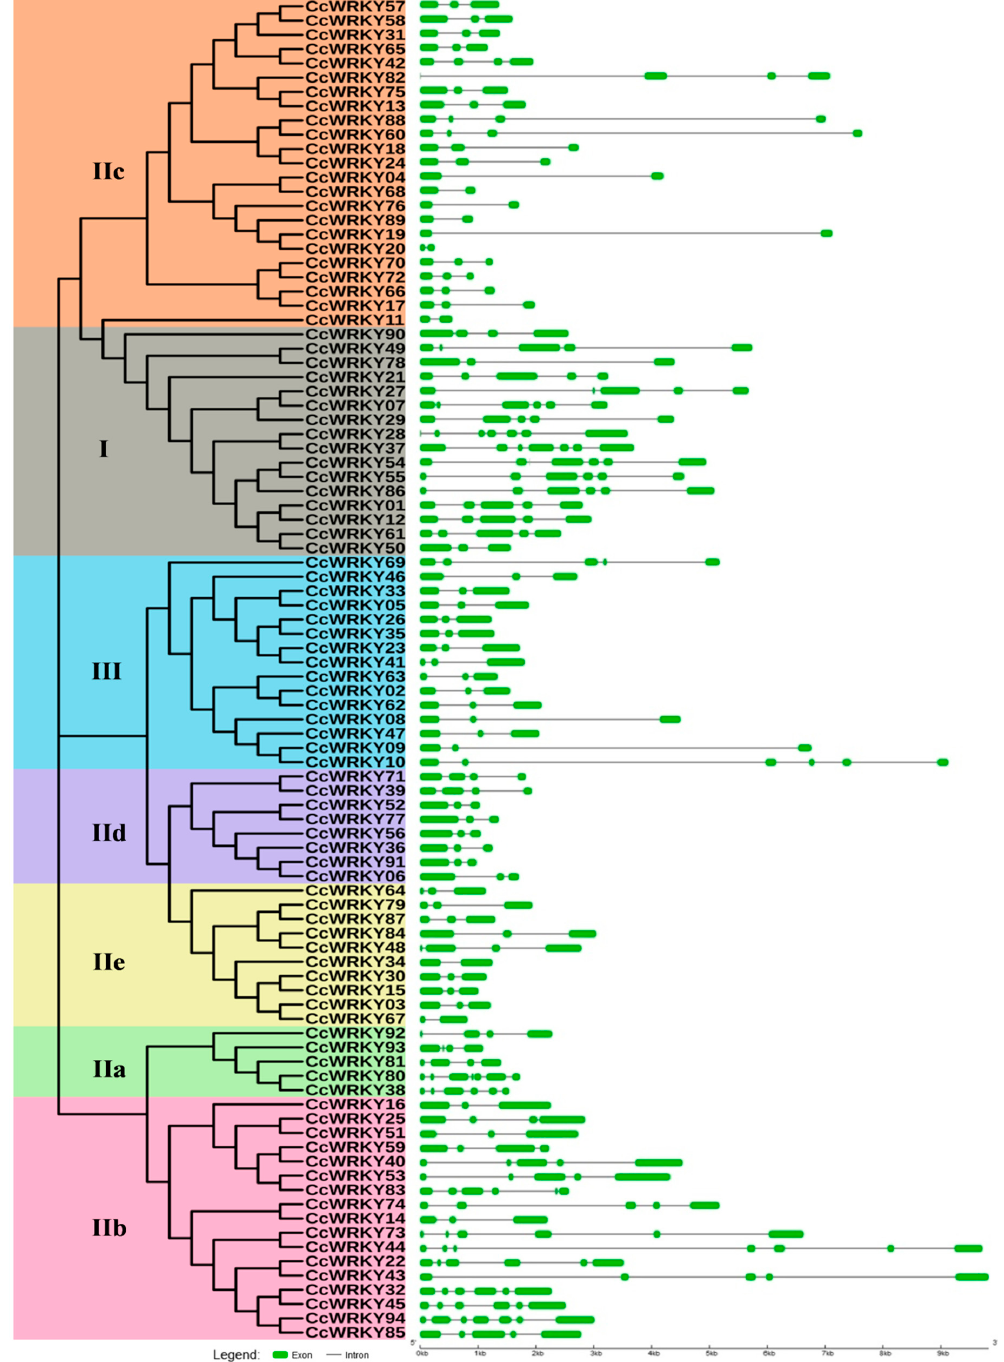
Figure 3. The intron-exon structure organization of 94 WRKY genes identified in pigeonpea genome. Exons and introns are indicated by solid green color boxes and solid black lines, respectively. The phylogenetic tree was constructed using the Neighbor-Joining method with 1000 bootstrap replicates.